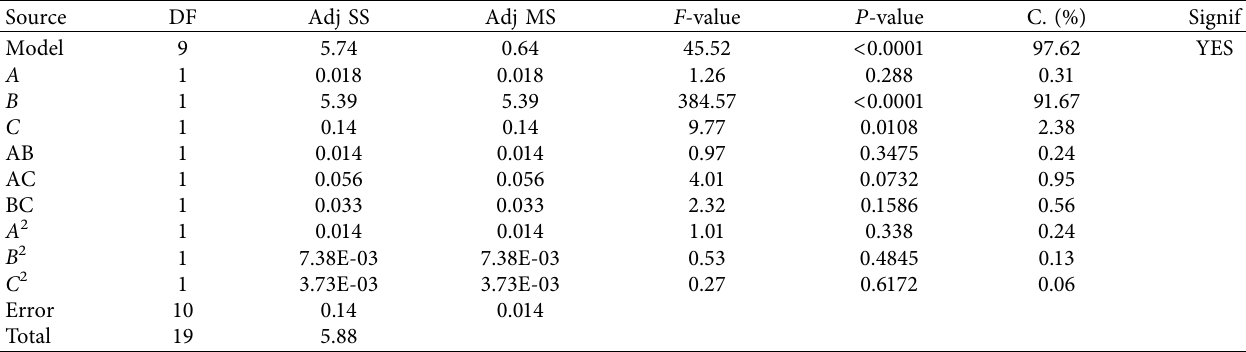
Table 5: Analysis of variance for Ra .